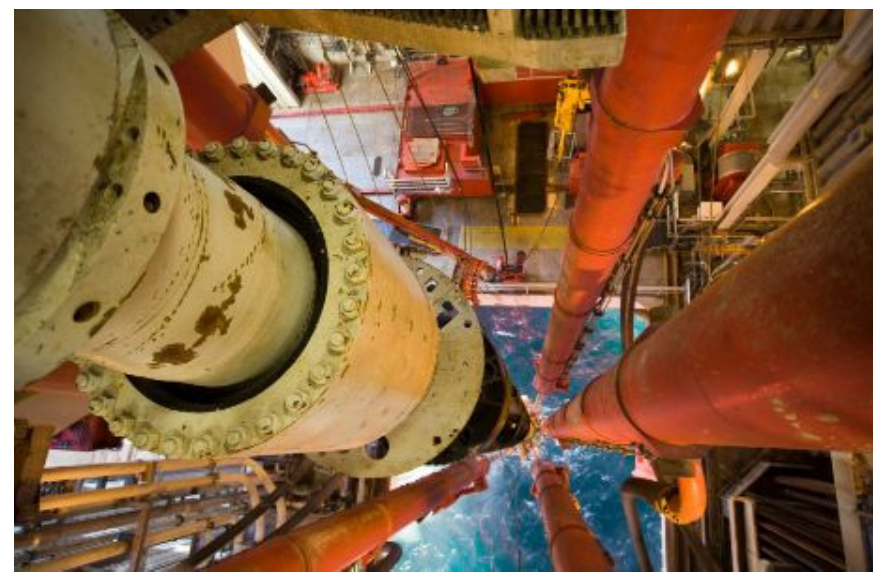
Figure 2. An aging offshore platform showing the marine riser.